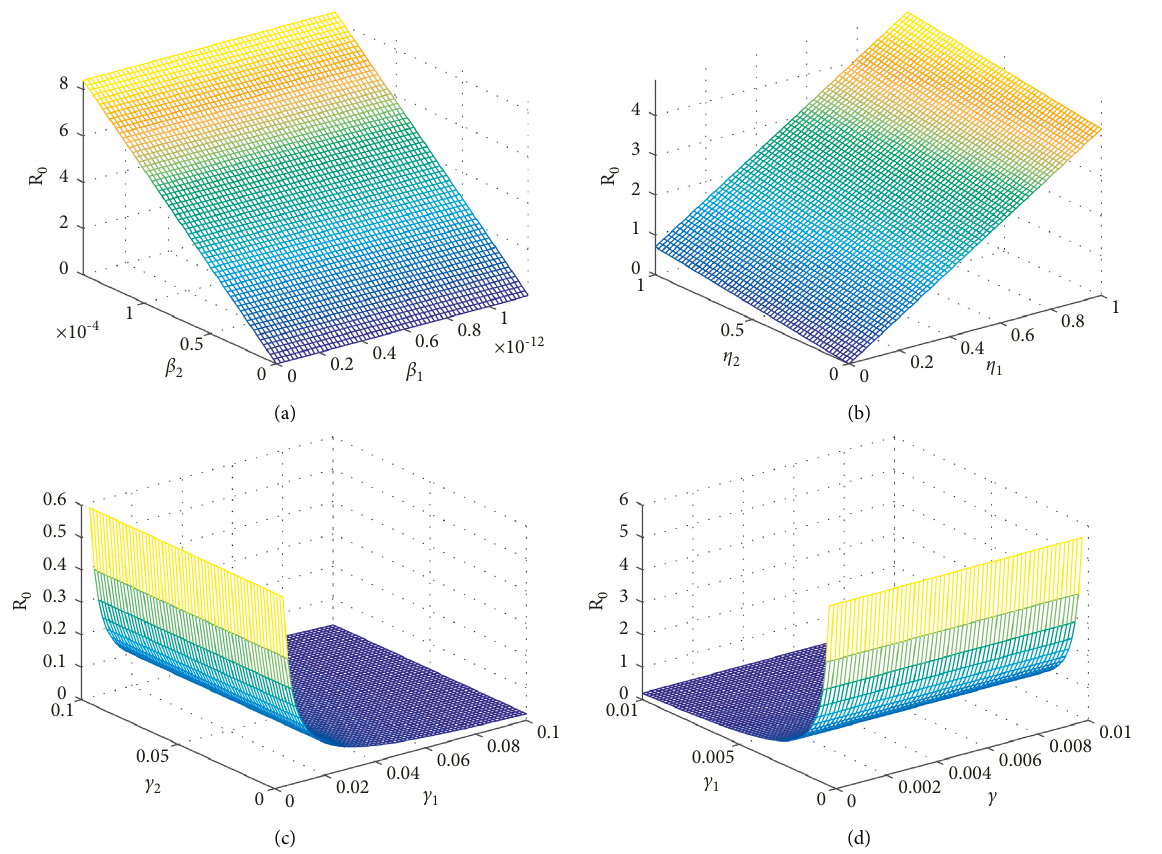
Figure 1: The graphical results demonstrate the local sensitivity analysis of the threshold quantity ( R ) with respect to the model parameters 0 � 0 . 0001847, c , β , η , η , c , c , and c . For this we use the parametric values as follows: Π � 0 . 2453, ψ � 0 . 00180, β β 1 2 1 2 1 2 1 c � 0 . 8631, c � 0 . 01470, β � 0 . 0004615, μ � 0 . 00130, μ � 0 . 00002, μ � 0 . 00230, c � 0 . 2381, η � 0 . 00200, c 4 1 2 1 0 2 1 � 0 . 00005. (a) R verses β and β . (b) R verses η and η . (c) R verses c and c . (d) R verses c and c η 0 0 0 1 2 0 1 2 1 2 1 2